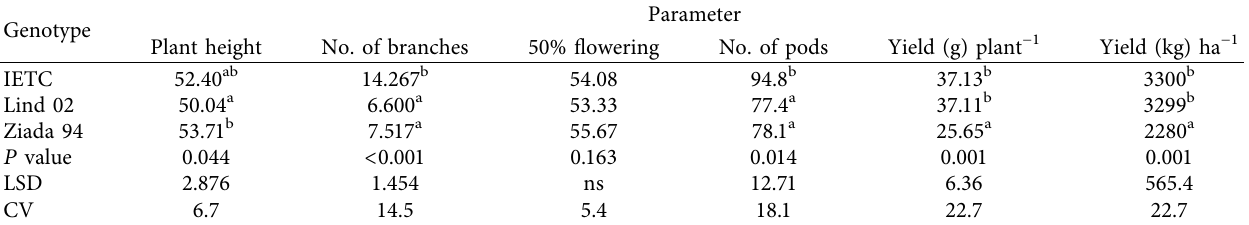
Table 3: The effect of different sesame varieties on vegetative and reproductive parameters.